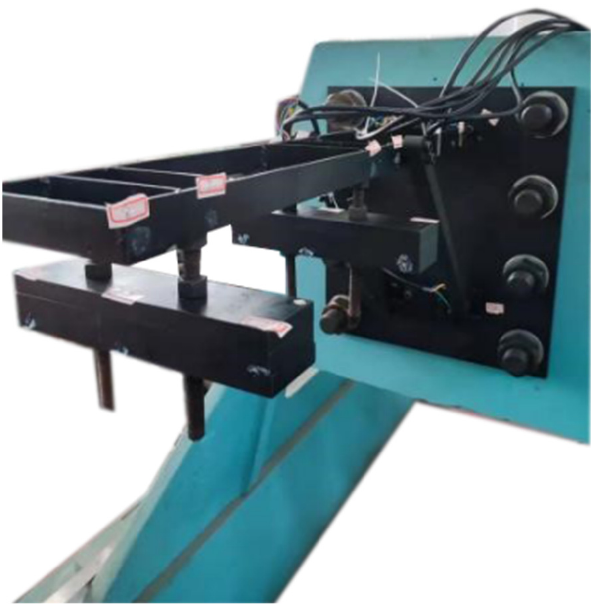
Figure 1. Test model of weapon pylon.